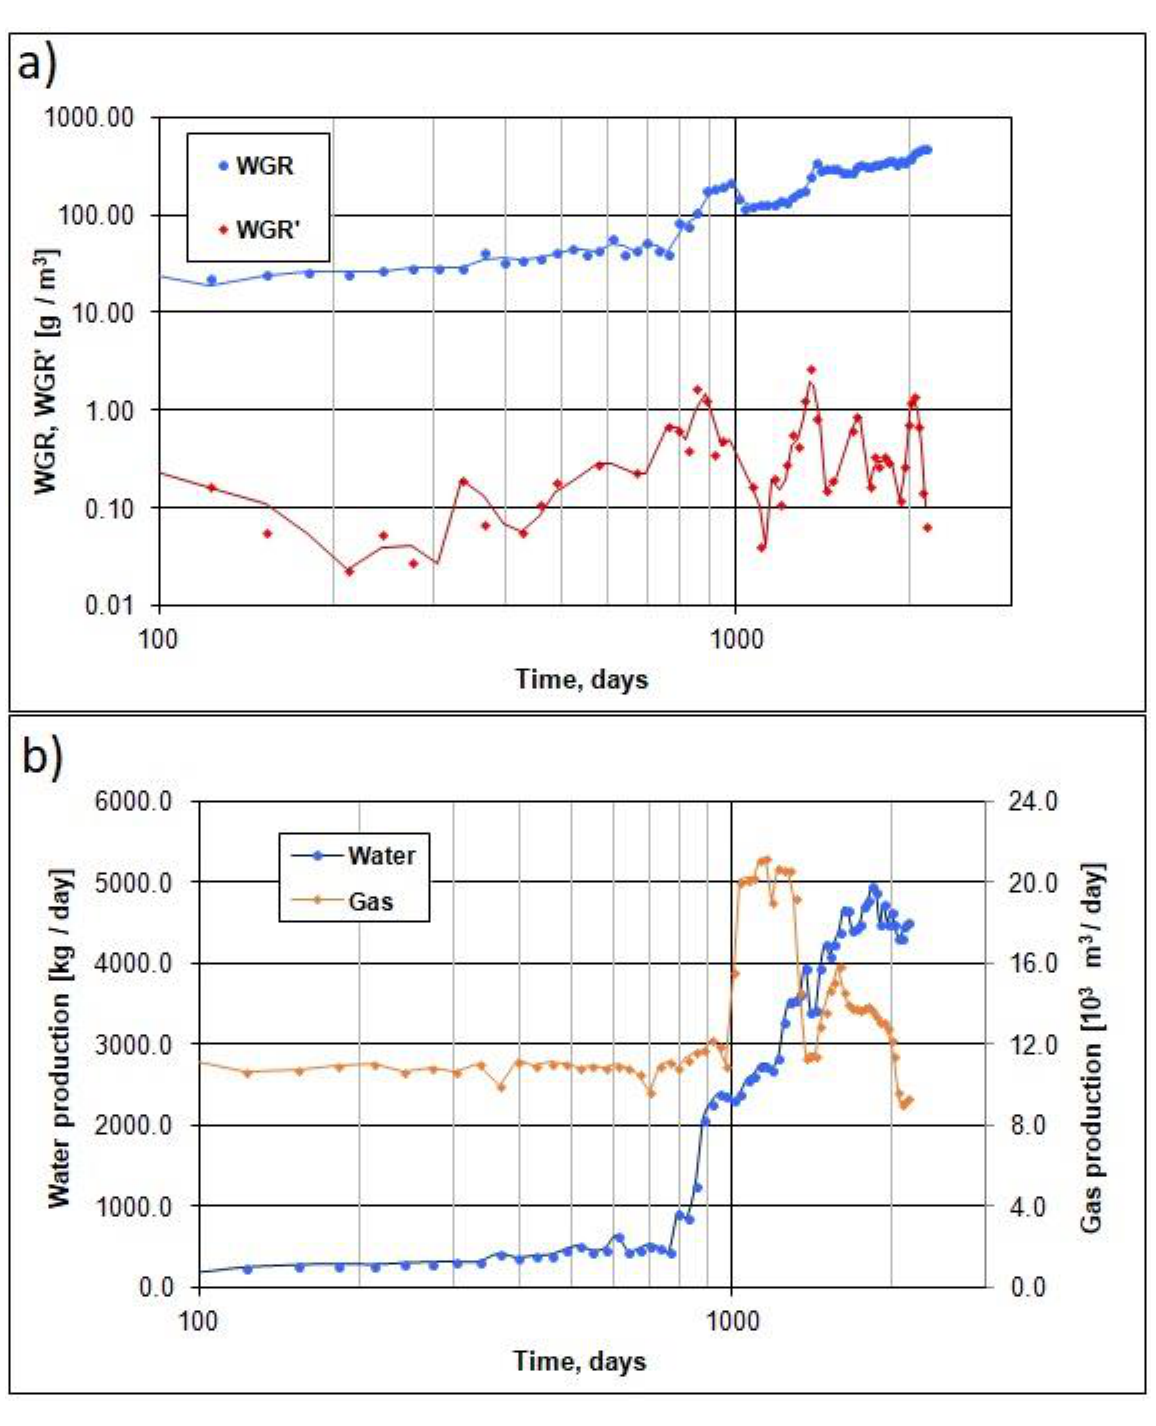
Figure 3. Changes in the WGR and its derivative over time ( a ) and the history of gas and formation water extraction ( b ) for the J-5K well .